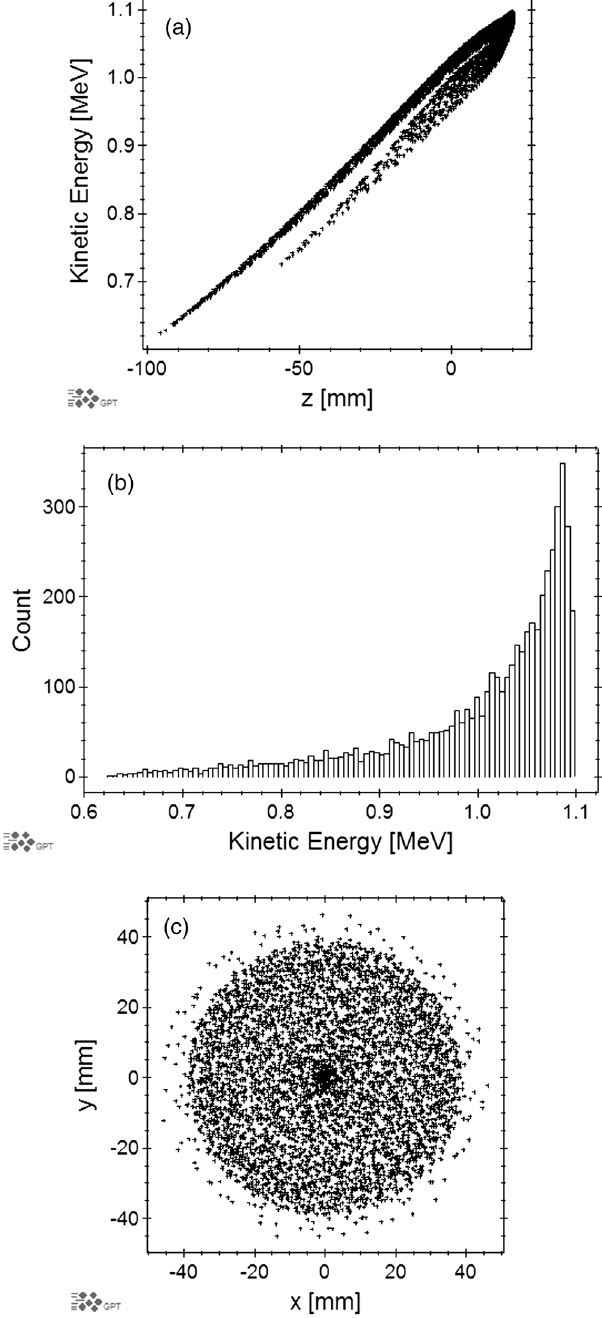
FIG. 4. Beam evolution through the accelerator: average kinetic energy (a), transverse rms bunch size (b), longitudinal rms bunch size (c), and rms energy spread (d).